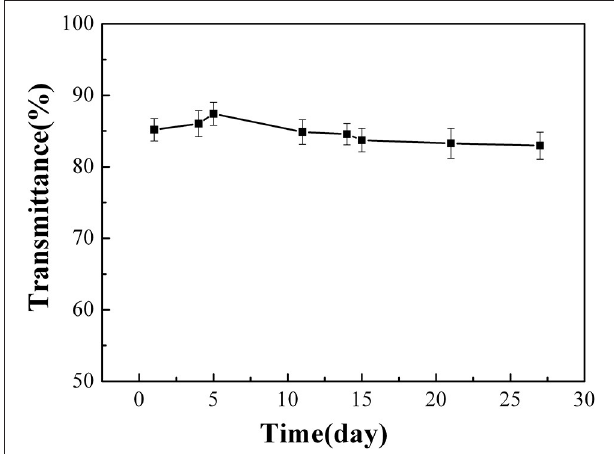
FIGURE 4 | The transmittance of BaF 2 :Nd NP dispersions (30 mg/mL) depends on different times.